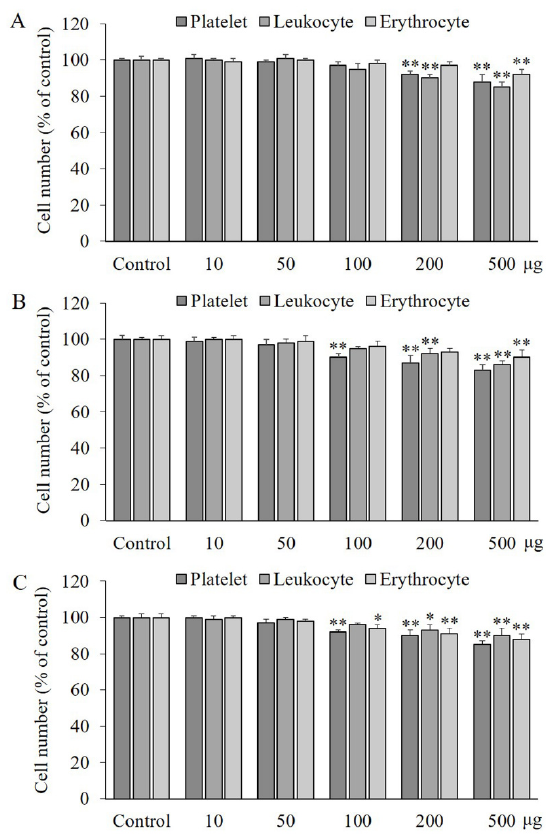
Figure 1. Blood cytotoxic effect of PA ( A ), IVA ( B ), and 4-HA ( C ). Aliquots of washed platelets (10 3 /mL), erythrocytes (10 6 /mL), and leukocytes (10 3 /mL) were treated with or without the compounds for 10 min and cell number was determined by hemocytometer counts. Each value is the mean ± SD of triplicate measurements. * p < 0.05 and ** p < 0.01, compared to each control groups. 10–500, 10–100 μg of each compound treated. 2.2. PA, IVA, and 4-HA Attenuate Fibrin/Blood Clot Formation As shown in Figure 2 , changes in the absorbance of fibrin polymer turbidity were tracked over time for 2000 s at 405 nm in each group. Fibrin polymers and clots were formed by the reaction of fibrinogen, thrombin, CaCl 2 , and different concentrations of compounds (1, 2, 5, 10, and 20 μg), and the absorbance of the clots increased gradually in the negative control group (NC) 2 group compared to the NC1 group treated with only fibrinogen and the PC group treated with fibrinogen, thrombin, and urokinase-type plasminogen activator (u-PA). At certain concentrations (1, 5, or 20 μg) of the compounds, the polymers were formed more rapidly, but eventually after the reaction time, fibrin polymer/clot formation was dose-dependently inhibited by PA, IVA, and 4-HA treatment ( Figure 2 A–C). In the fibrin clot assay, clots were strongly formed by thrombin activation in the NC group compared to the NC group containing only fibrinogen ( Figure 2 D). PA, IVA, 4-HA, and u-PA inhibited fibrin clot formation by 66.9 ± 3.3,